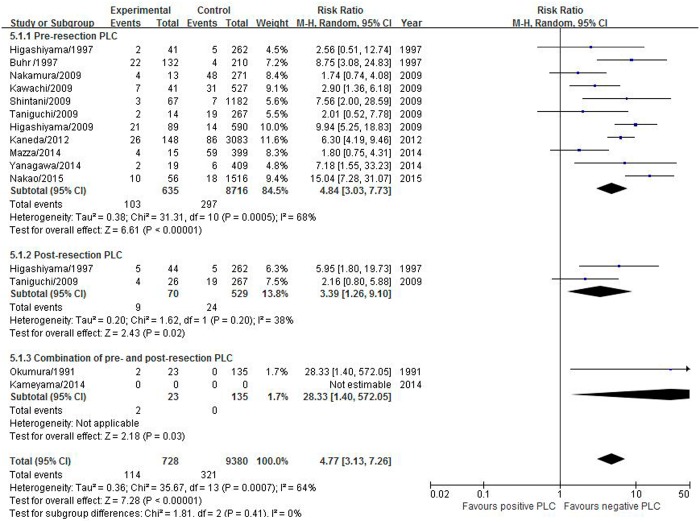
Effect of positive PLC on the pleural recurrence.